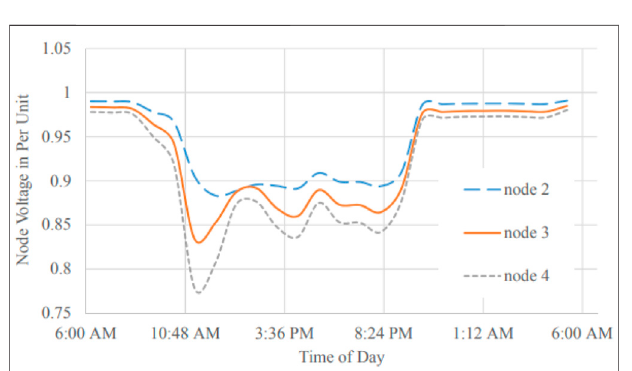
FIGURE 11 | Utility forecast 03 node voltages with